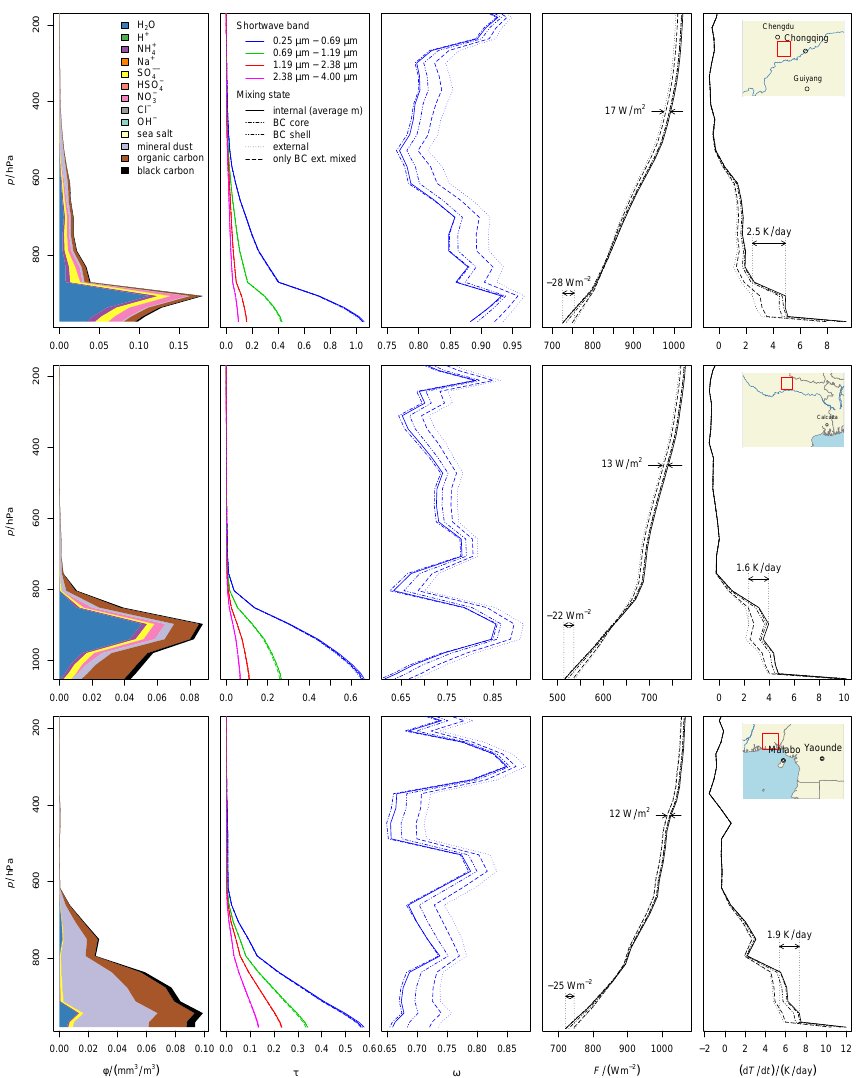
Figure 11. Column model results over (from top to bottom) the Sichuan Basin in China (29 . 72 ◦ N, 104 . 62 ◦ E; April), the Gangetic Plain in India (26 . 35 ◦ N, 84 . 37 ◦ E; November) and the eastern Niger Delta in Nigeria (5 . 05 ◦ N, 7 . 87 ◦ E; January). From left to right: aerosol concentrations, aerosol optical depth τ , single-scattering albedo ω , net shortwave flux F , temperature tendency d T/ d t . The optical depth is shown for each shortwave band, whereas the single-scattering albedo is shown only for the dominant band (0.25–0.69µm). The flux takes all solar bands into account; in addition, the temperature tendency takes the effects of terrestrial infrared radiation into